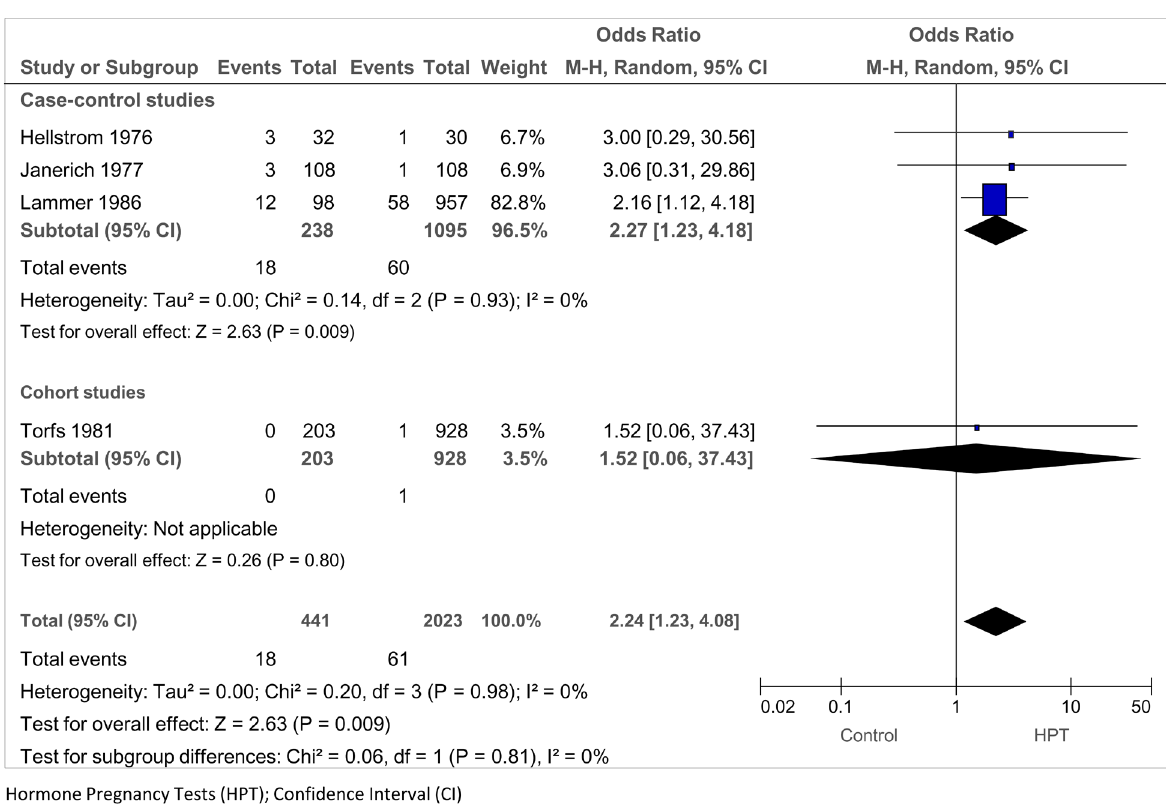
A relation between the exposure to oral HPTs and